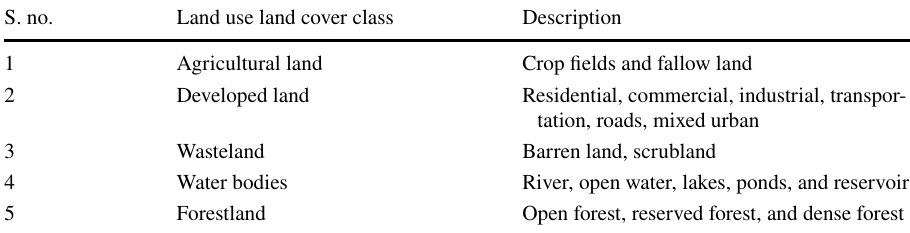
Table 2 Land use/land cover types on the basis of supervised